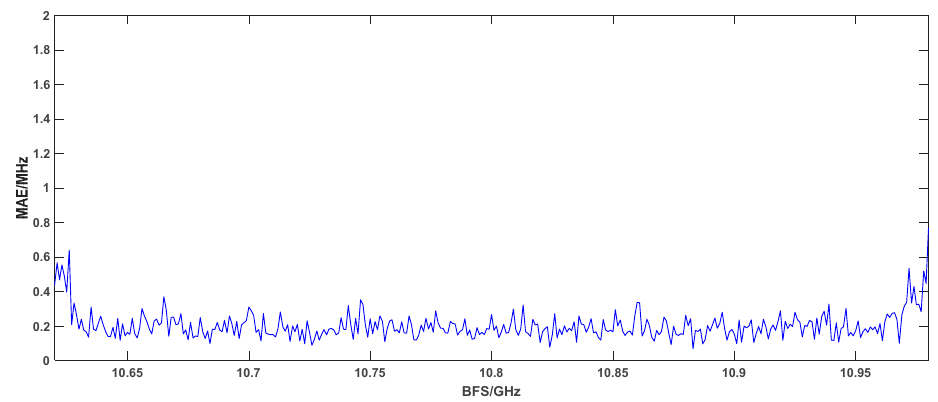
Figure 5. MAEs of the proposed method at different BFS. MAEs are less than 0.4 MHz between 10.65 GHz and 10.95 GHz.